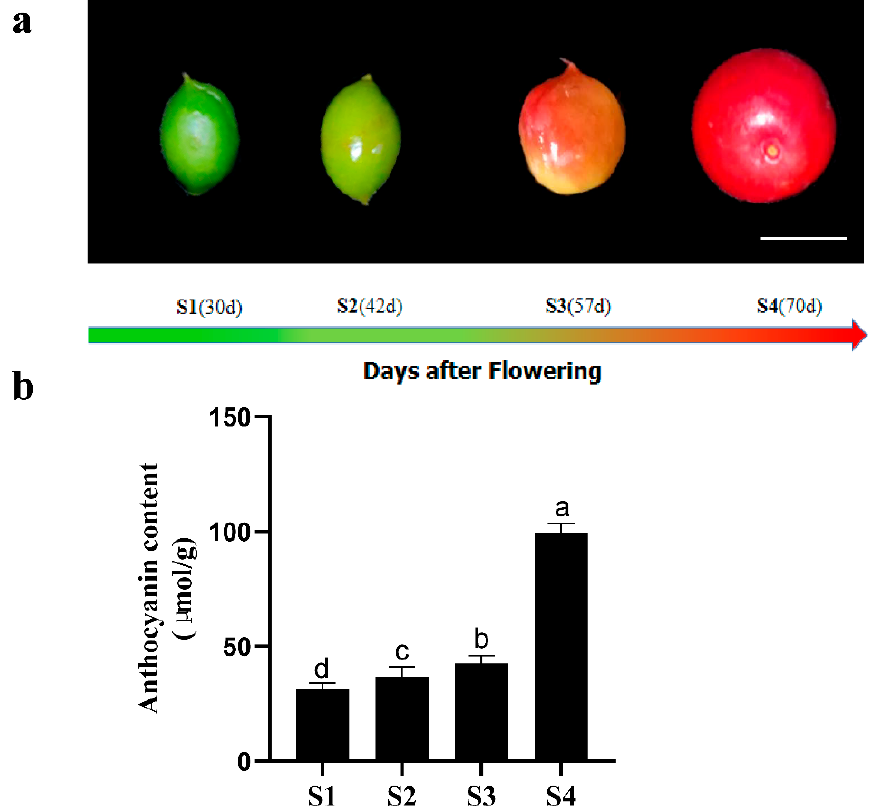
Figure 1. Pigmentation and phenotypes of Cerasus humilis fruit peel during four stages. ( a ) fruit phenotypes: young fruit (S1), green fruit (S2), slightly red fruit (S3), and red fruit (S4). ( b ) anthocyanin content of four stages of Cerasus humilis fruit peel. Scale bar, 1 cm. Lowercase letters indicate significant differences at p <